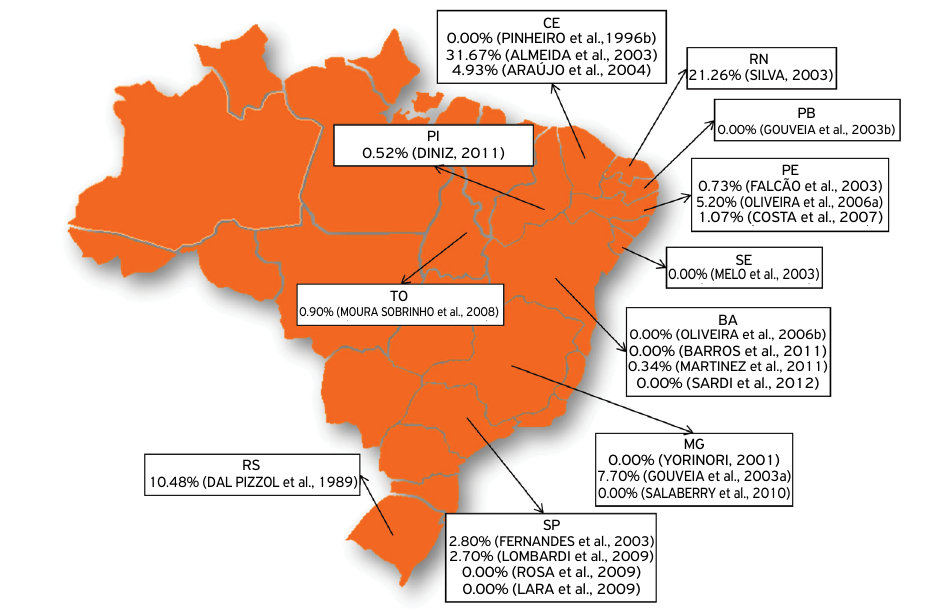
Figure 1. Seropositivity for lentiviruses of small ruminants in sheep from different states in Brazil.